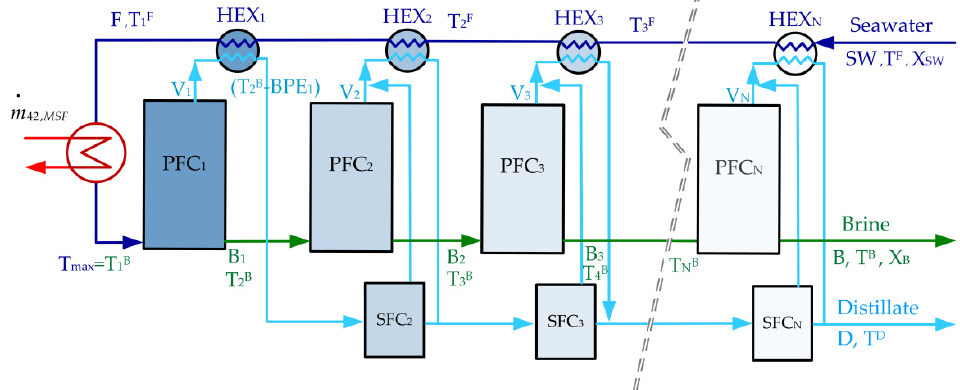
Figure A1. Schematic of a multi-stage flash MSF seawater desalination process.